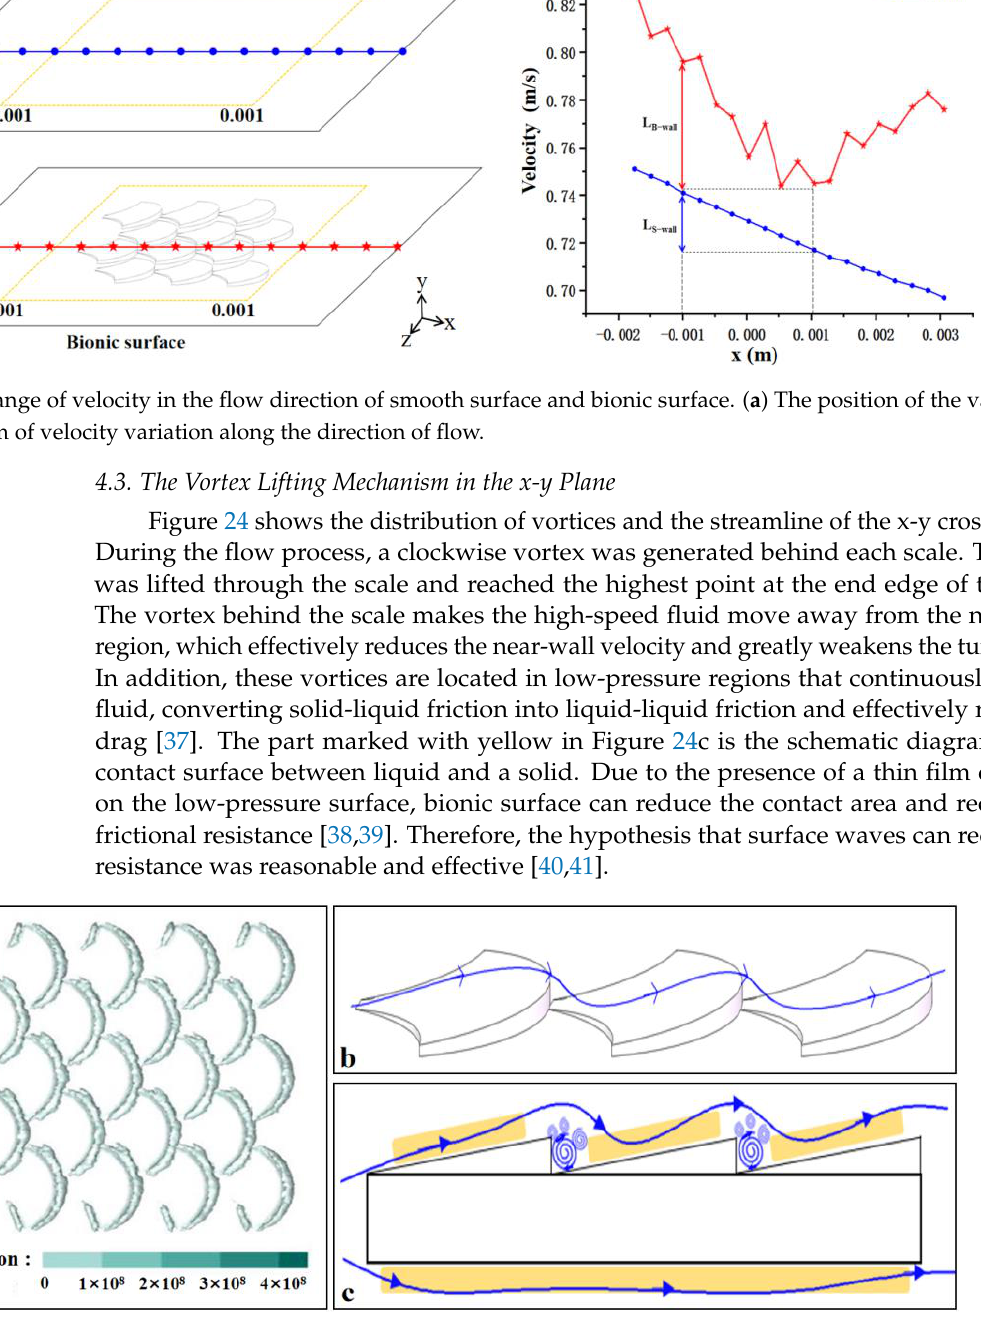
Figure 22. Velocity distribution of each scale column. ( a ) Average velocity on each of scale column; ( b ) The velocity distri- bution of each column.